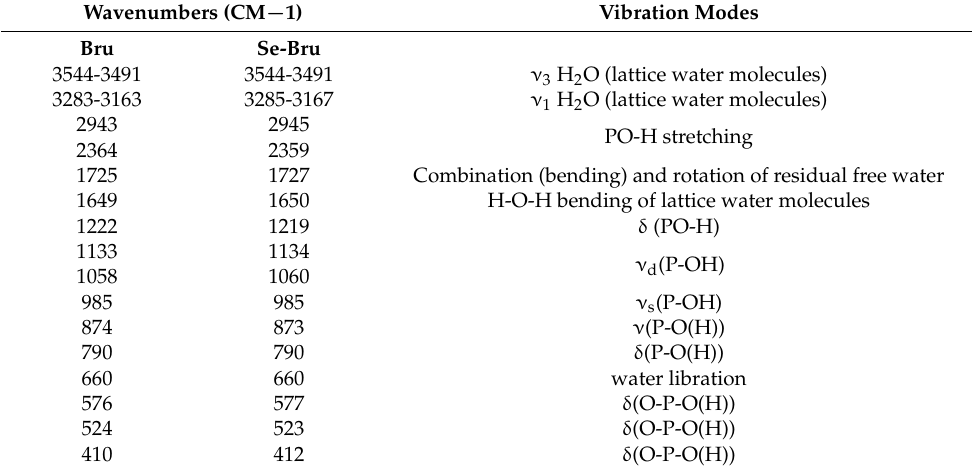
Table A2. Infrared bands (cm − 1 ) for the Bru and Se-Bru samples and their assignments